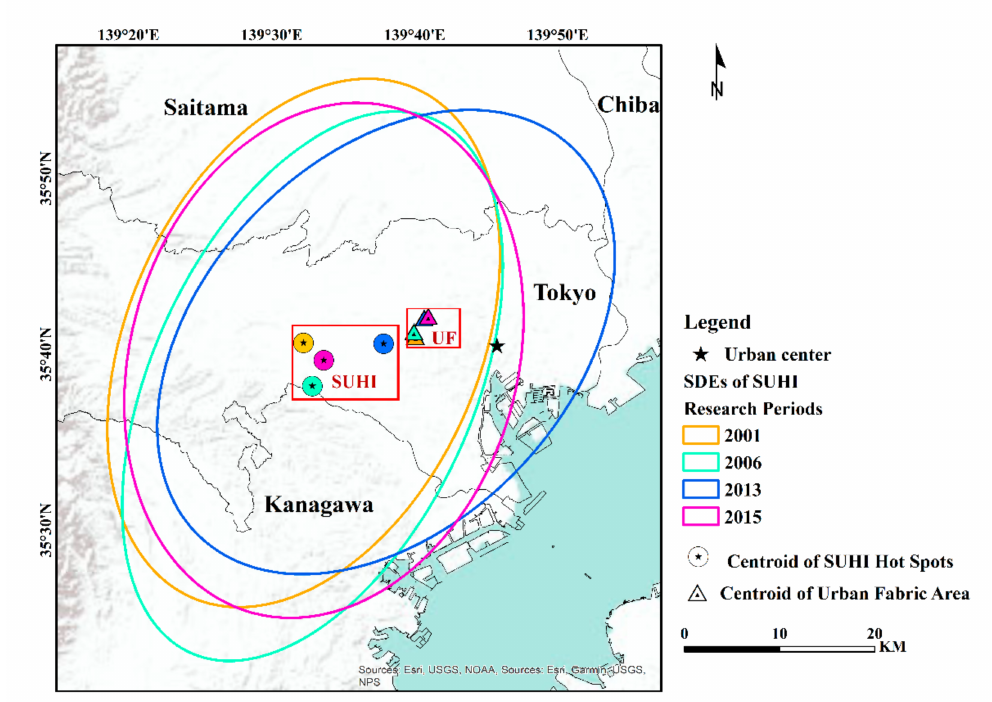
Figure 8. Centroid trajectories and moving directions of SUHI hot spots and urban areas in